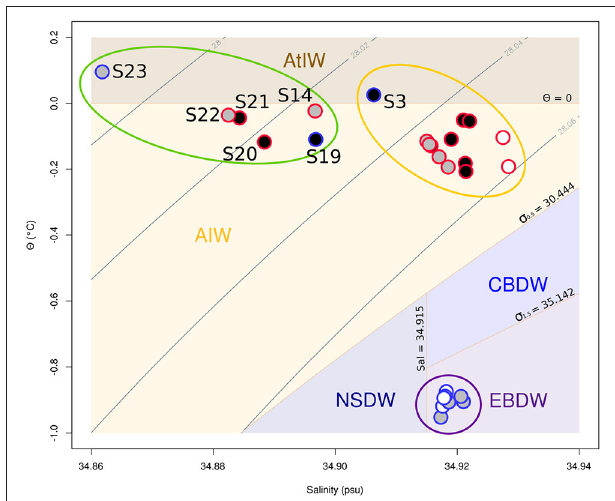
FIGURE 4 | Θ -S plot of all the samples from the study. Gray contour lines represent isopycnals of the potential density σ 2 . The domain of the different water masses is shown as defined by Rudels et al. (2005). AtlW is here used as a simplification for several water masses found in the Greenland sea. Samples in black were used for 16S rRNA profiling only, samples in white for g23 profiling only, and samples in gray for both type of profiling. Red and blue borders on the samples represent plumes and background samples, respectively. The purple, orange, and green ellipses represent the groups P1, P2, and P3, respectively. The samples from the group V1 are found within the purple ellipse. The group V2 is made of the gray and white samples within the orange and green ellipses. AtIW, Atlantic Intermediate Water; AIW, Arctic Intermediate Water; NSDW, Norwegian Sea Deep Water; CBDW, Canadian Basin Deep Water; EBDW, Eurasian Basin Deep